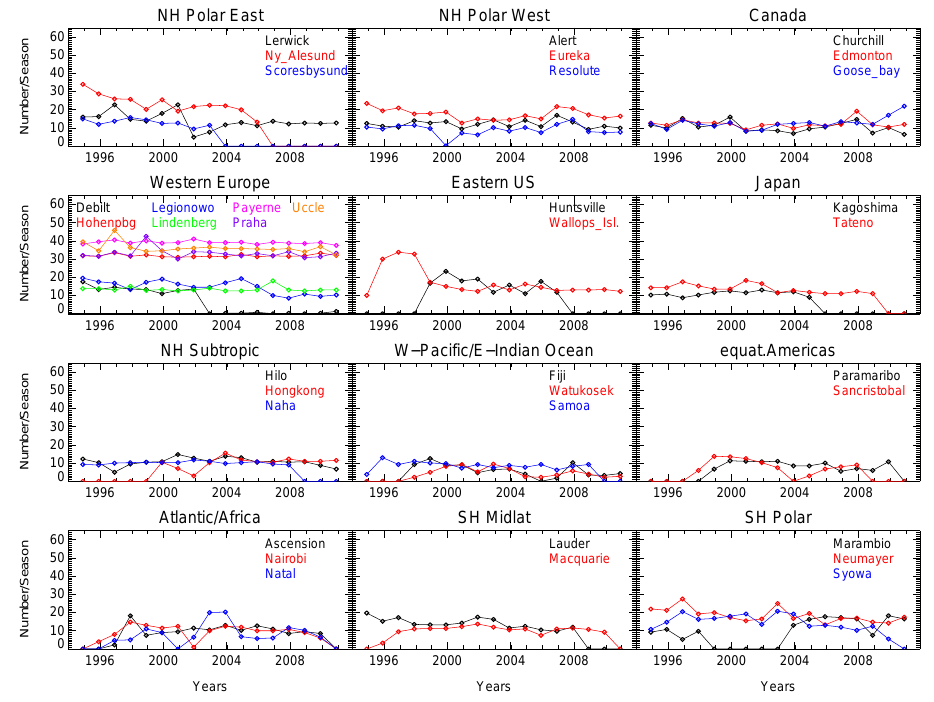
Fig. 4. Averaged number of profiles per season and year between 1995 and 2011 for each site within each region.